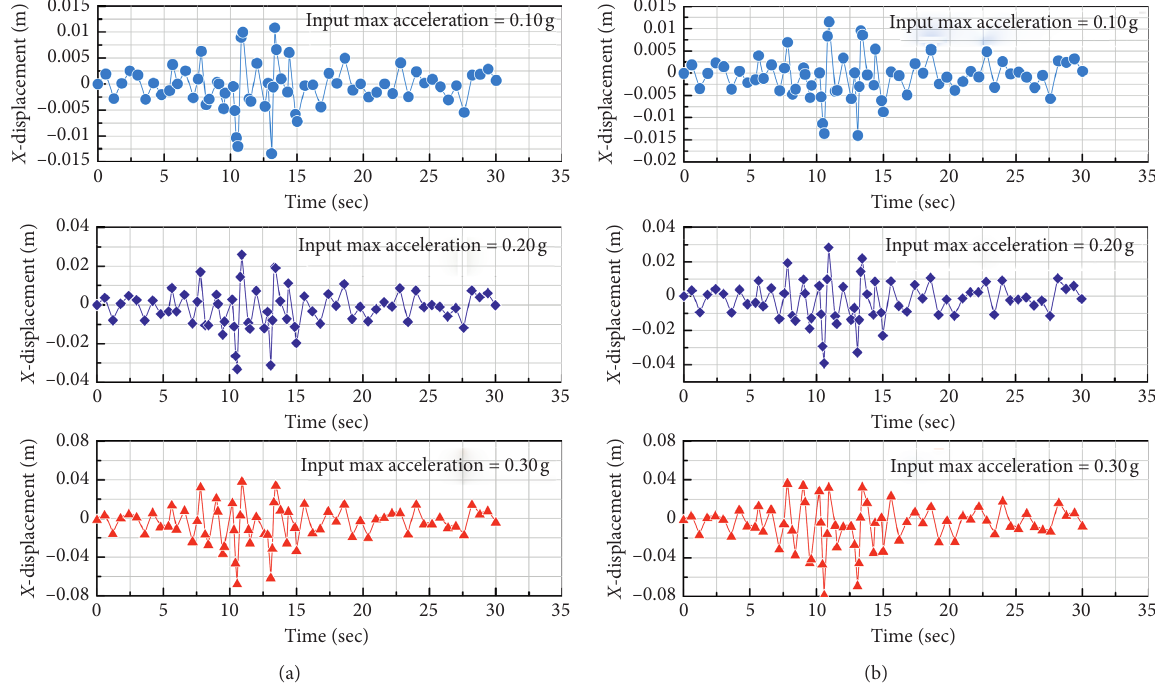
Figure 14: Time-course curves of horizontal displacement of third subdam and ash storage field under three input earthquakes ( L (a) Third subdam. (b) Ash storage